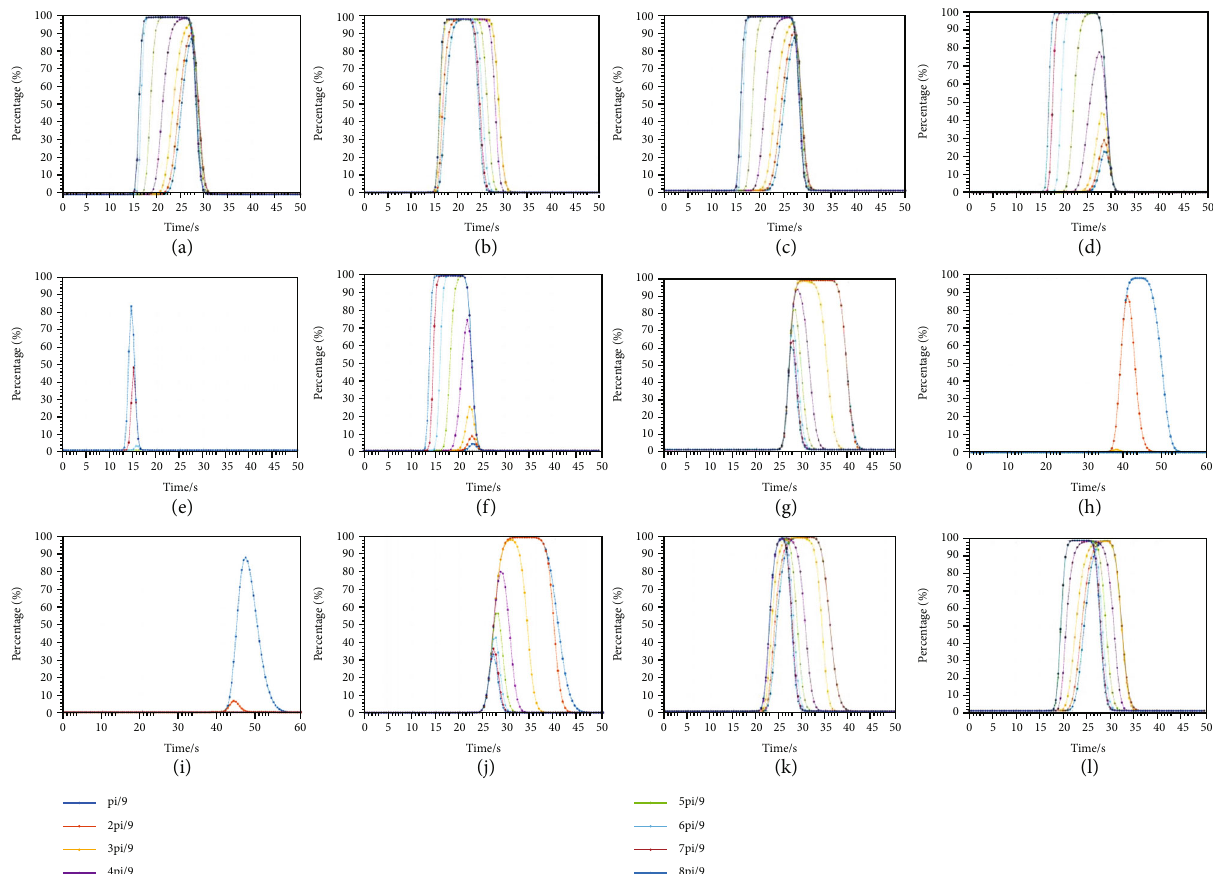
Figure 14: Con fl ict risk assessment of MAV constant airspeed decline and UAV constant airspeed climb in high-level airspace ( fl ight altitude 4200-7800 m) versus θ ∈ ½ π /9, 8 π /9 (cid:2) , V = 720 Km/h , and V = 224Km/h . Results are averaged over 1000 simulations. MAV UAV Unbolded curves in the illustration indicate con fl ict probability < 10 ð − 7 Þ . (a) H = 2000 , d = 3 × 10 3 , θ = − 20 π /180 , θ = 20 π /180 ; 3 MAV 3 UAV (b) H = 2000 , d = 4 × 10 3 , θ = − 20 π /180 , θ = 20 π /180 ; (c) H = 2000 , d = 5 × 10 3 , θ = − 20 π /180 , θ = 20 π /180 ; (d) H = 3 MAV 3 UAV 3 MAV 3 UAV 2000 , d = 5 : 5 × 10 3 , θ = − 20 π /180 , θ = 20 π /180 ; (e) H = 800 , d = 5 × 10 3 , θ = − 20 π /180 , θ = 20 π /180 ; (f) H = 1500 , d 3 MAV 3 UAV 3 MAV 3 UAV = 5 × 10 3 , θ = − 20 π /180 , θ = 20 π /180 ; (g) H = 3000 , d = 5 × 10 3 , θ = − 20 π /180 , θ = 20 π /180 ; (h) H = 4000 , d = 5 × 10 3 3 MAV 3 UAV 3 MAV 3 UAV , θ = − 20 π /180 , θ = 20 π /180 ; (i) H = 4500 , d = 5 × 10 3 , θ = − 20 π /180 , θ = 20 π /180 ; (j) H = 2000 , d = 5 × 10 3 , θ = 3 MAV 3 UAV 3 MAV 3 UAV 3 MAV − 13 π /180 , θ = 13 π /180 ; (k) H = 2000 , d = 5 × 10 3 , θ = − 15 π /180 , θ = 15 π /180 ; (l) H = 2000 , d = 5 × 10 3 , θ = − 17 π /180 3 UAV 3 MAV 3 UAV 3 MAV = 17 π /180 , θ 3 UAV